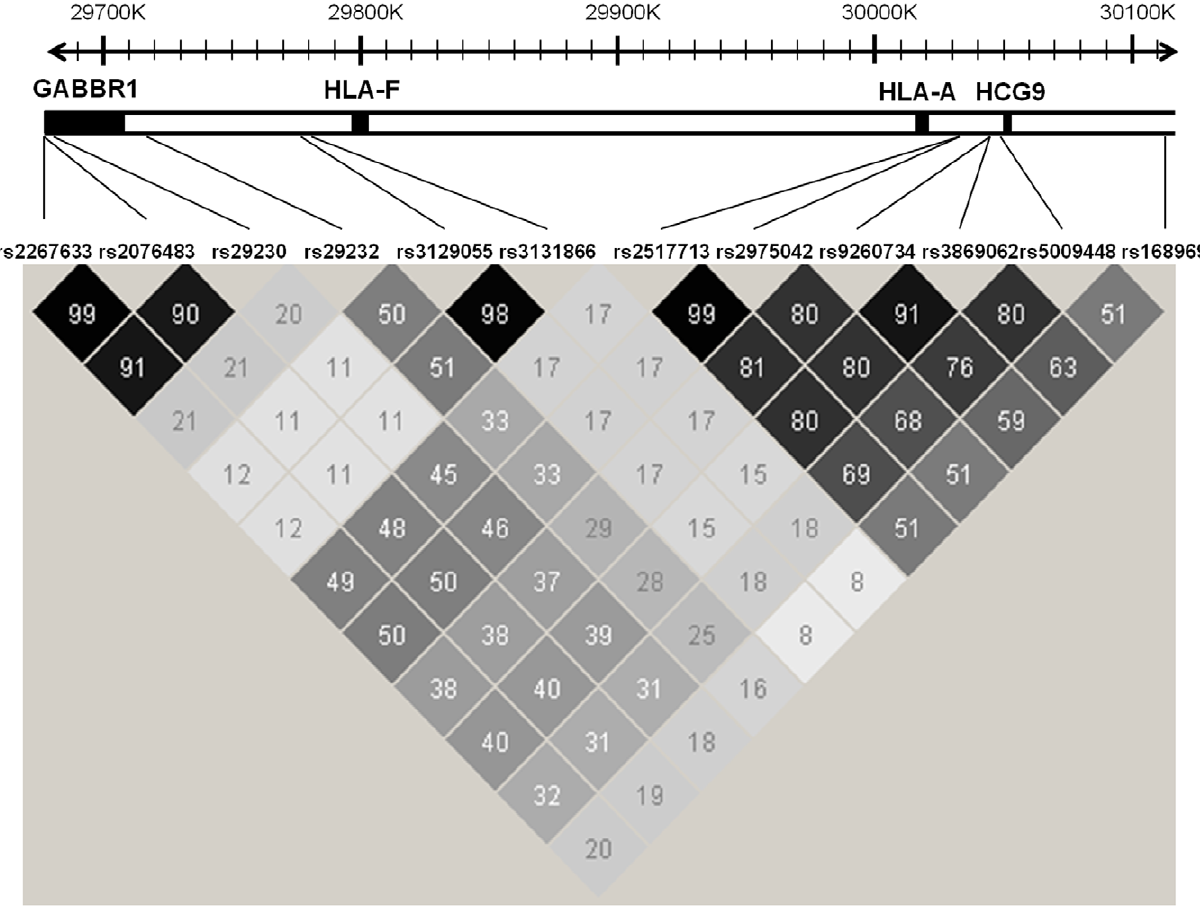
Table 1. After adjustment for age, gender, study, and HLA-A , a significant association remained for a single SNP located within